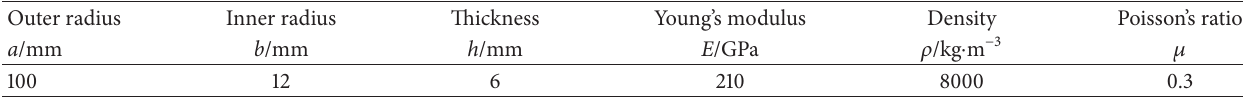
Table 1: The geometric sizes and material parameters.